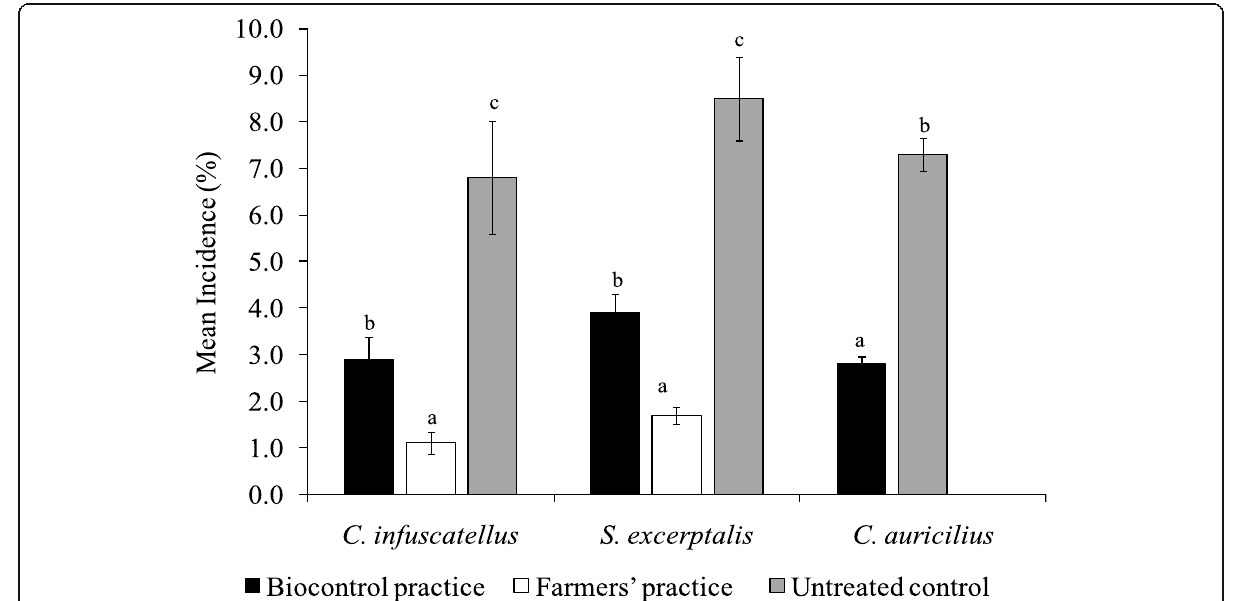
Fig. 1 Mean incidence of sugarcane borers in different management practices (pooled mean of 5 years); values followed by different letters in the columns for respective borers are significantly different at P = 0.05